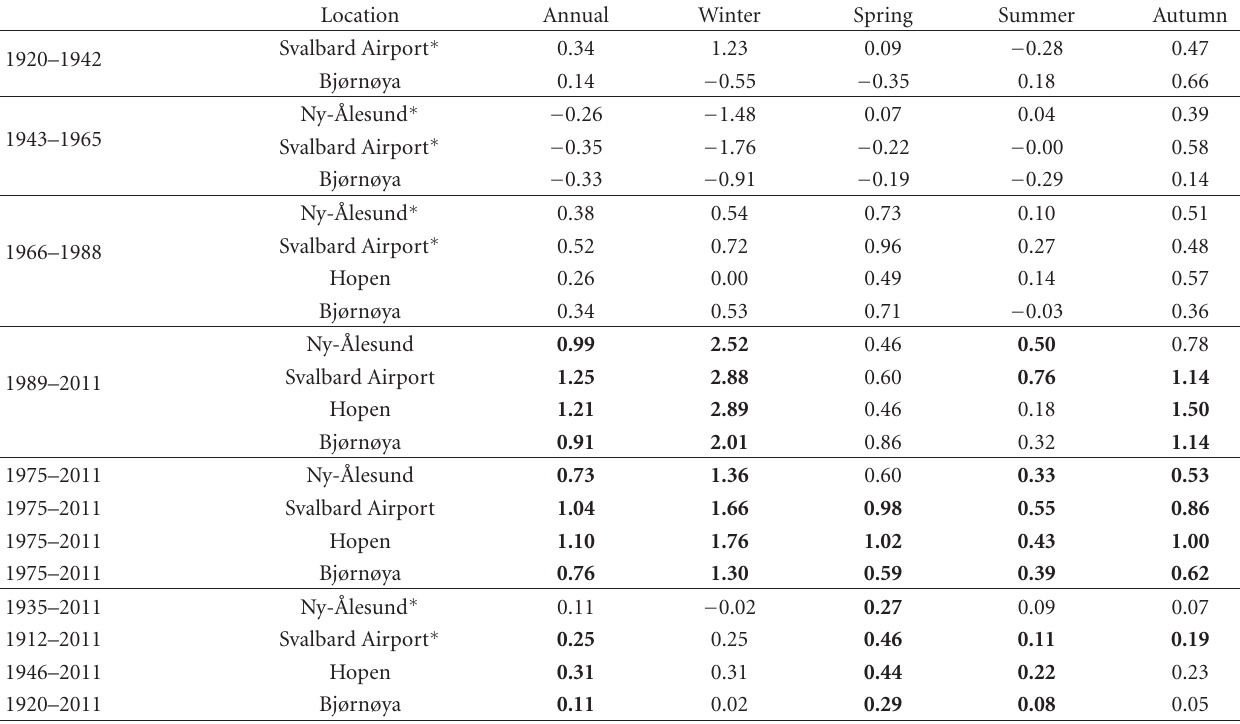
Table 2: Linear temperature trends ( ◦ C per decade) in di ff erent time periods for stations in the Svalbard region. Trends significant at the 5% level are bold (Mann-Kendall nonparametric test [21]).